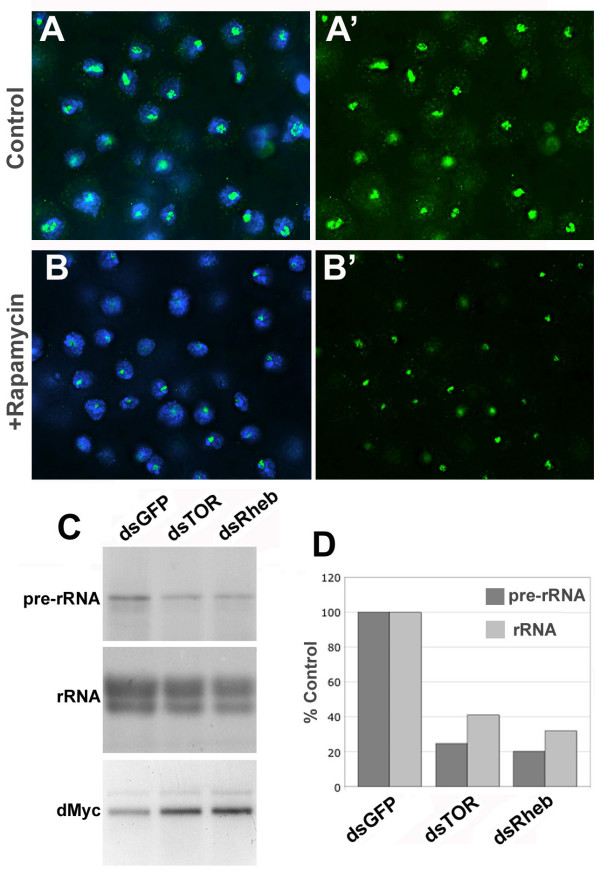
Rheb and TOR regulate ribosome biogenesis. (A, B) Nucleoli visualized by anti-fibrillarin staining (green) [84], in S2 cells treated with (A) DMSO or (B) rapamycin for 16h. DNA was visualized using Hoechst 33258 (blue). (C) Northern blots of RNA from S2 cells treated for 72h with the indicated dsRNA. A probe for an internal transcribed spacer (ITS) region of the rDNA was used to detect pre-rRNA. Total rRNA was detected with ethidium bromide. A probe for dMyc transcript was used as a loading control. (D) Quantification, using ImageJ software, of pre-rRNA and total rRNA, relative to dMyc mRNA, from the samples shown in (C).